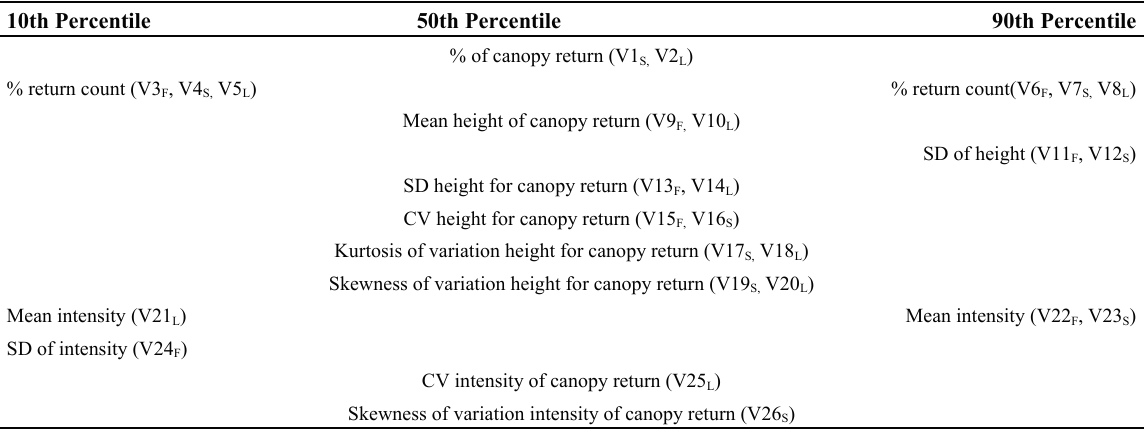
Table 2. List of selected vertical profile features, F = first; S = single; L = last; SD = standard deviation; CV = coefficient of